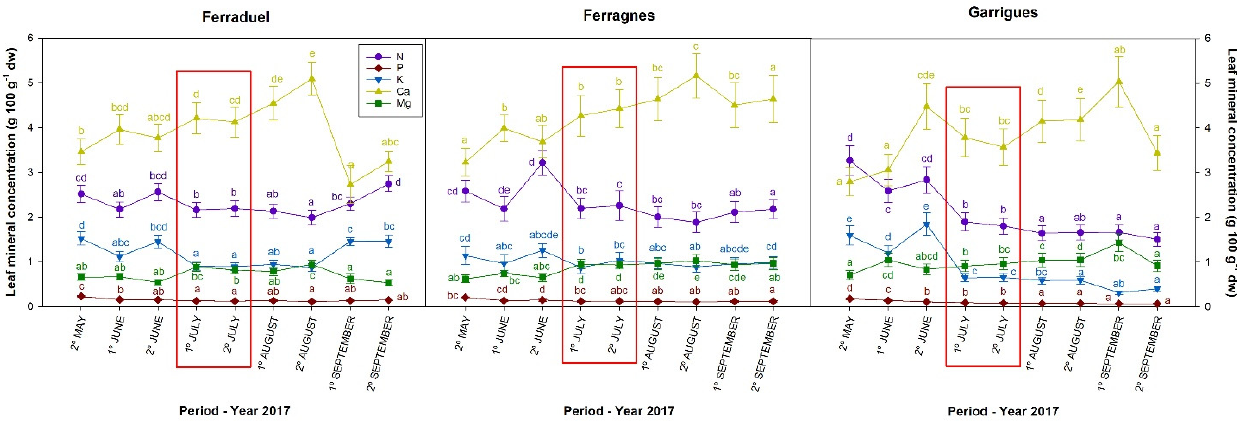
Figure 1. The evolution of the concentration of macronutrients at different leaf collecting dates in the Ferraduel, Ferragnes, and Garrigues varieties. The red square indicates the simultaneous period of greater stability in the five nutrients. Values are the average ± standard error ( n = 12). For every cultivar and nutrient, the different lowercase letters indicate significant differences between the sampling date for p < 0.001 established by Tukey’s multiple range test.